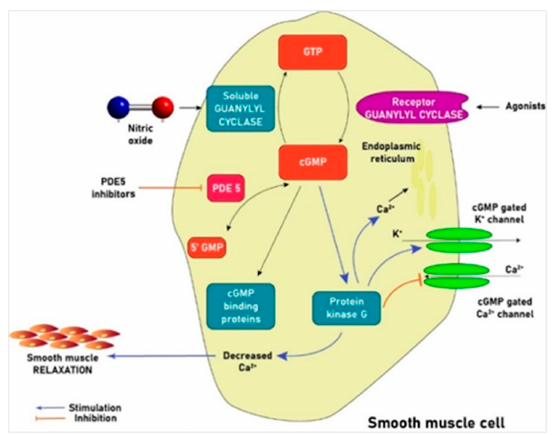
Figure 1. PDE5I-induced smooth muscle relaxation in the corpora cavernosa. cGMP is the principal mediator of NO-induced smooth muscle relaxation/vasodilation [35]. cGMP propels a series of intracellular changes including inhibition of Ca 2+ entry into the cell, Ca 2+ shift into the endoplasmic reticulum, activation of K + channels leading to membrane hyperpolarization, and stimulation of a cGMP-dependent protein kinase that activates a myosin light chain phosphatase. All these actions promote smooth muscle relaxation. NO penetrates the cytoplasm of smooth muscle cells binding to guanylyl cyclase (sGC), which catalyzes the enzymatic conversion of GTP to cGMP. Elevation of cGMP stimulates cGMP-dependent protein kinase G leading to PDE5 phosphorylation / activation. PDE5 hydrolyzes cGMP in the cavernosal tissue. Inhibition of PDE5 results in smooth muscle relaxation with increased arterial blood flow, leading to compression of the sub-tunical venous plexus followed by penile erection